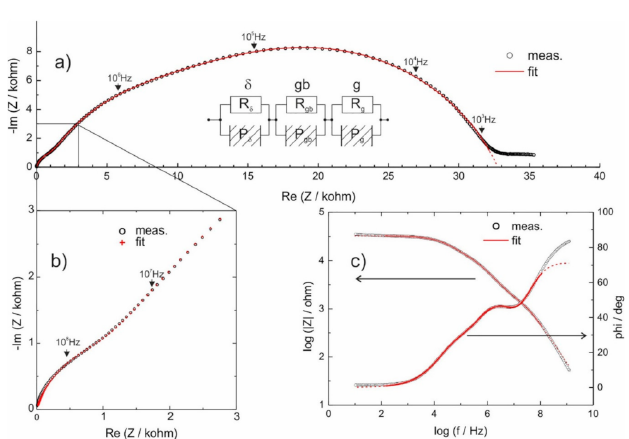
Figure 17. ( a ) Impedance spectrum of a sample heat-treated at 530 ◦ C, measured in a frequency range 10 GHz–10 Hz (fitted in the 200 MHz–200 Hz range). Open circles denote experimental points, the solid line corresponds to the numerical fit using the equivalent circuit shown in the inset. ( b ) A magnified high-frequency part of the spectrum a) (marked by a solid line box). Open circles denote experimental points and “+” correspond to fits. ( c ) Impedance spectrum in the Bode representation. (Reproduced with permission from ref. [79]. Copyright 2018,